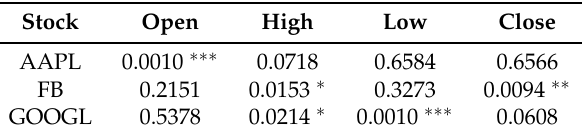
Table 1. p -values from the Ljung–Box test for independencies of stock return series: Open, High, Low, and Close. “*” indicates that the p -value is statistically significant at α = 5%, “**” indicates that the p -value is statistically significant at α = 1%, and “***” indicates that the p -value is statistically significant at α =